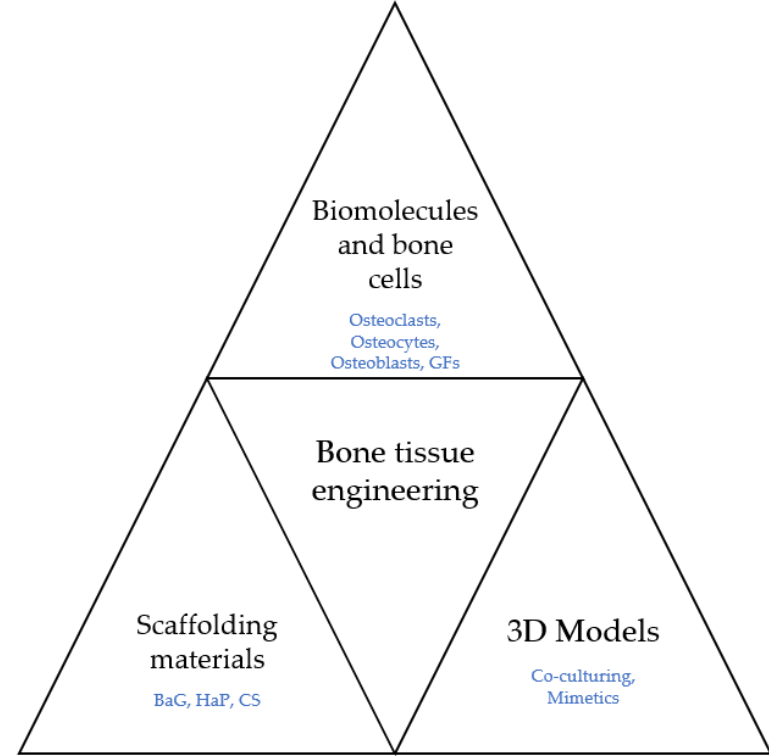
Figure 5 . The fields involved in BTE. Figure 5. The fields involved in